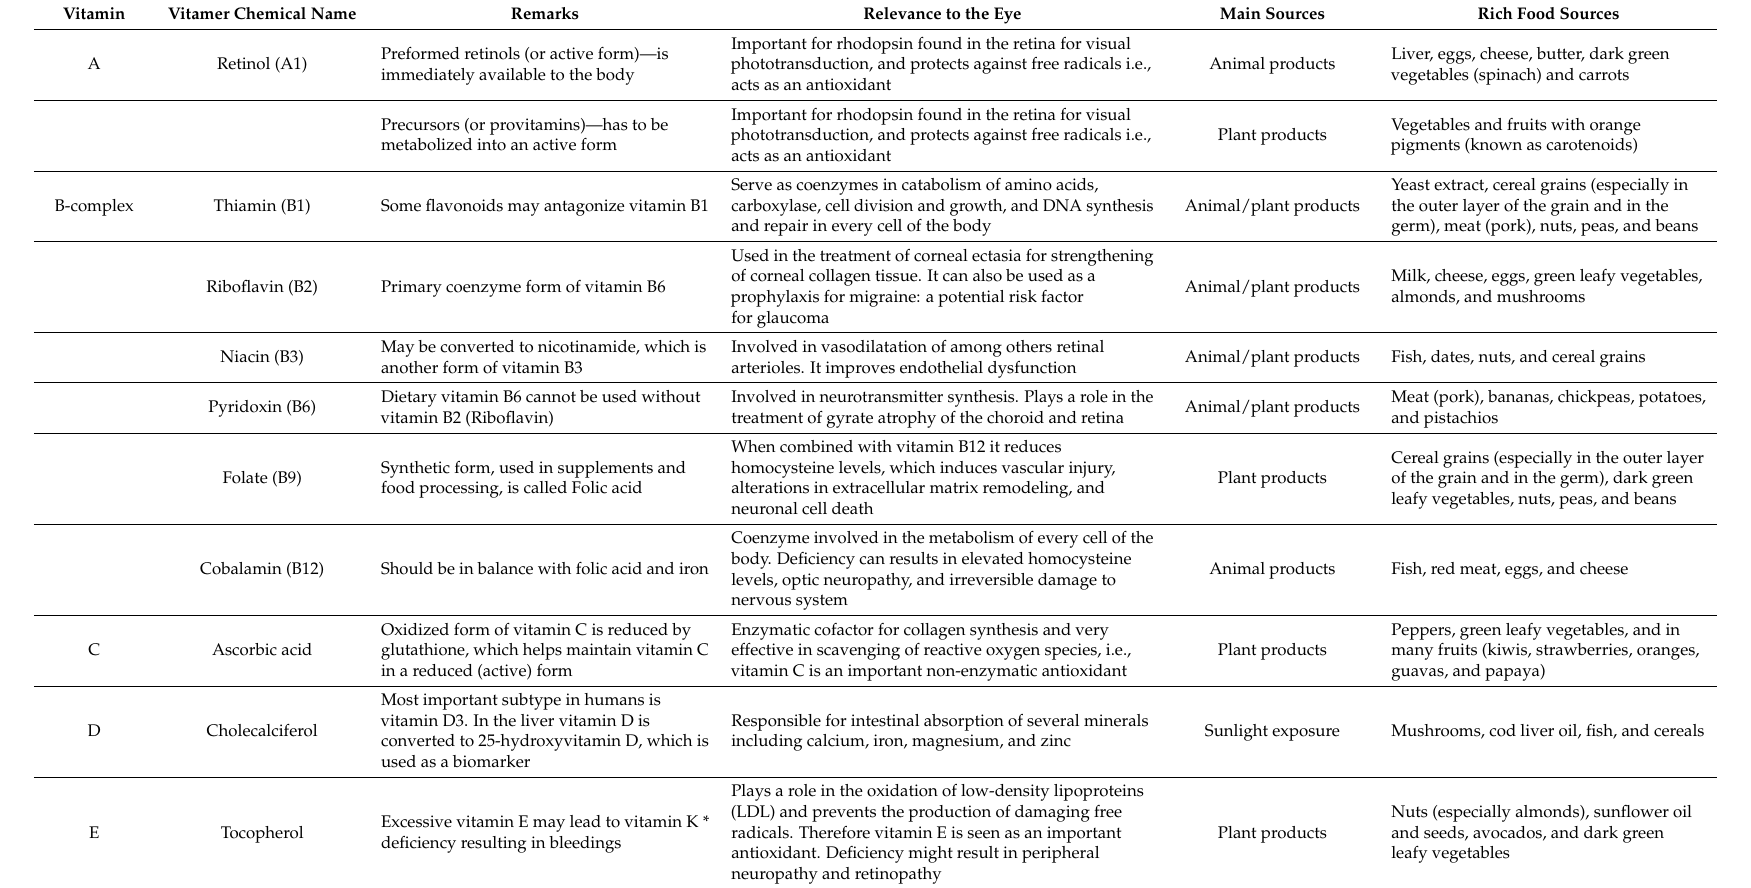
Table 1. Overview of investigated vitamins retrieved from the systematic